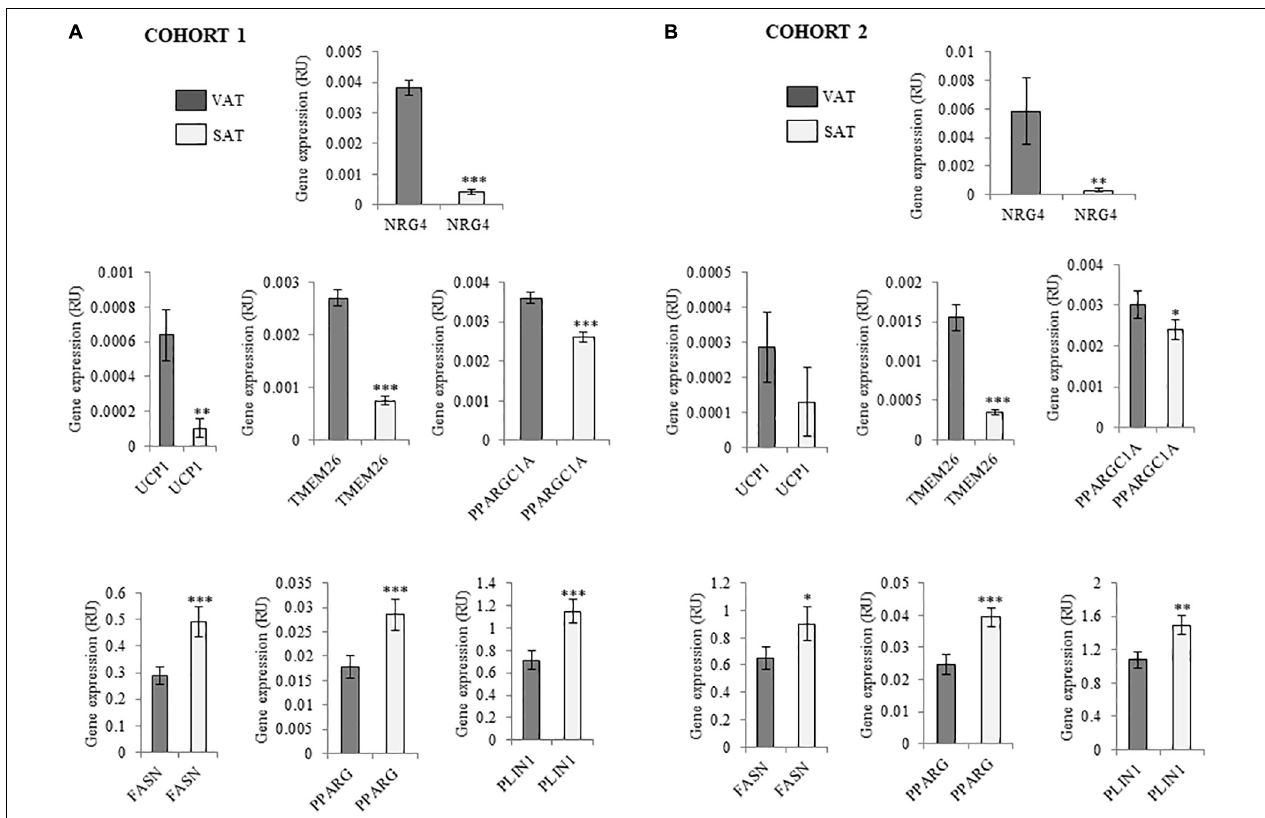
FIGURE 1 | (A,B) Comparison of NRG4, UCP1, TMEM26, PPARGC1A, FASN, PPARG, and PLIN1 gene expression in paired VAT and SAT in cohort 1 ( n = 132) (A) and cohort 2 ( n = 20) (B) . ∗ p < 0.05, ∗∗ p < 0.01, and ∗∗∗ p < 0.001 compared to gene expression in VAT.